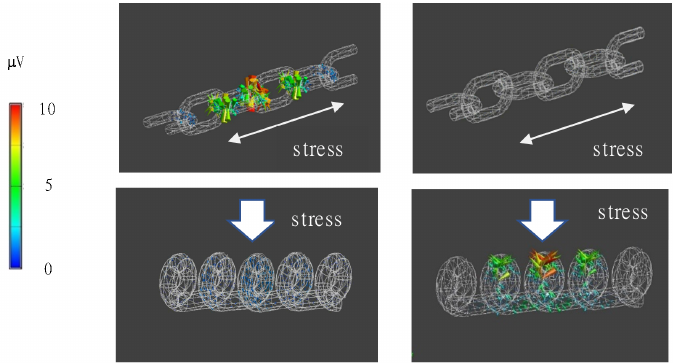
Figure 7. Piezoelectric response of piezoelectric braided cord that mimics embroidery stitches.